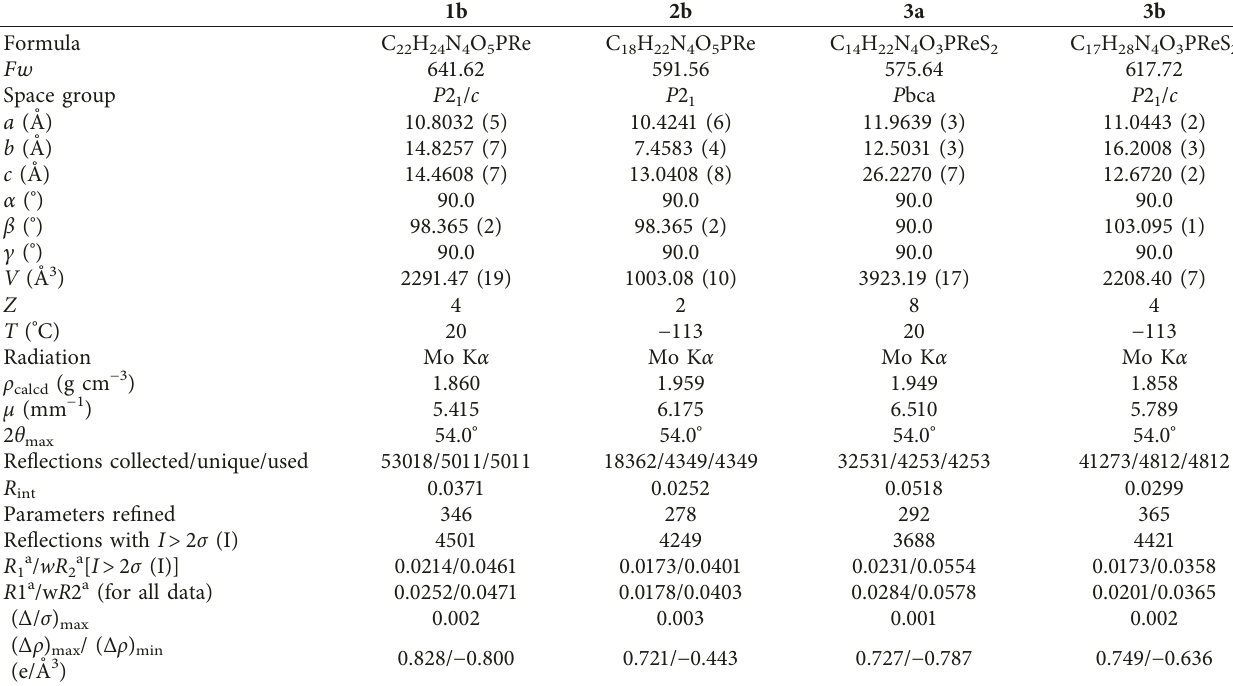
Table 1: Crystallographic data for complexes 1b , 2b , 3a, and 3b